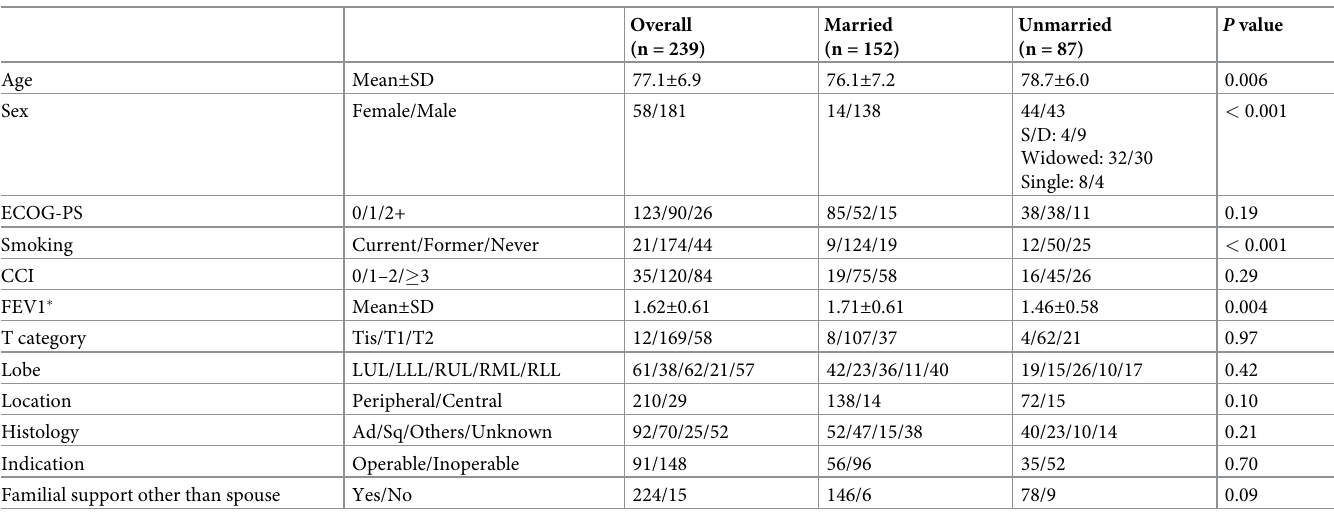
Table 1. Patient characteristics.